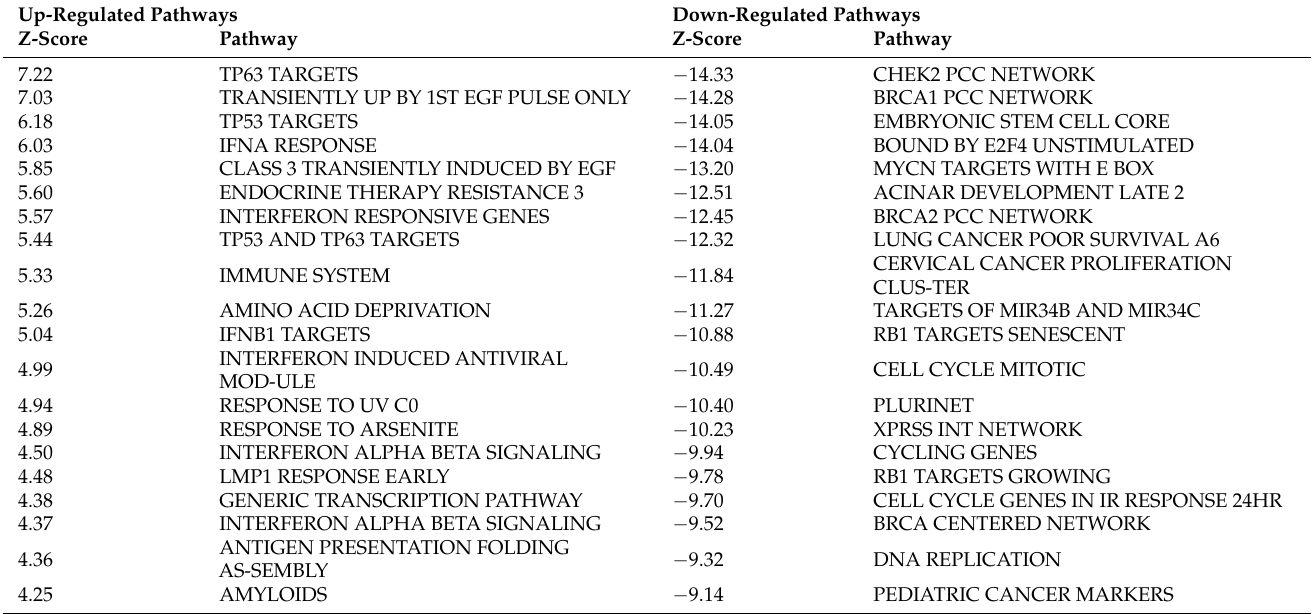
Table 3. The positive and negative enrichment of pathways in the AM630 transcriptional response of the core cell population. AM630 up regulates an immune response together with TP53 and interferon and a down regulation of cell cycle and cancer-associated pathways. See Table S5 for a full list of enriched